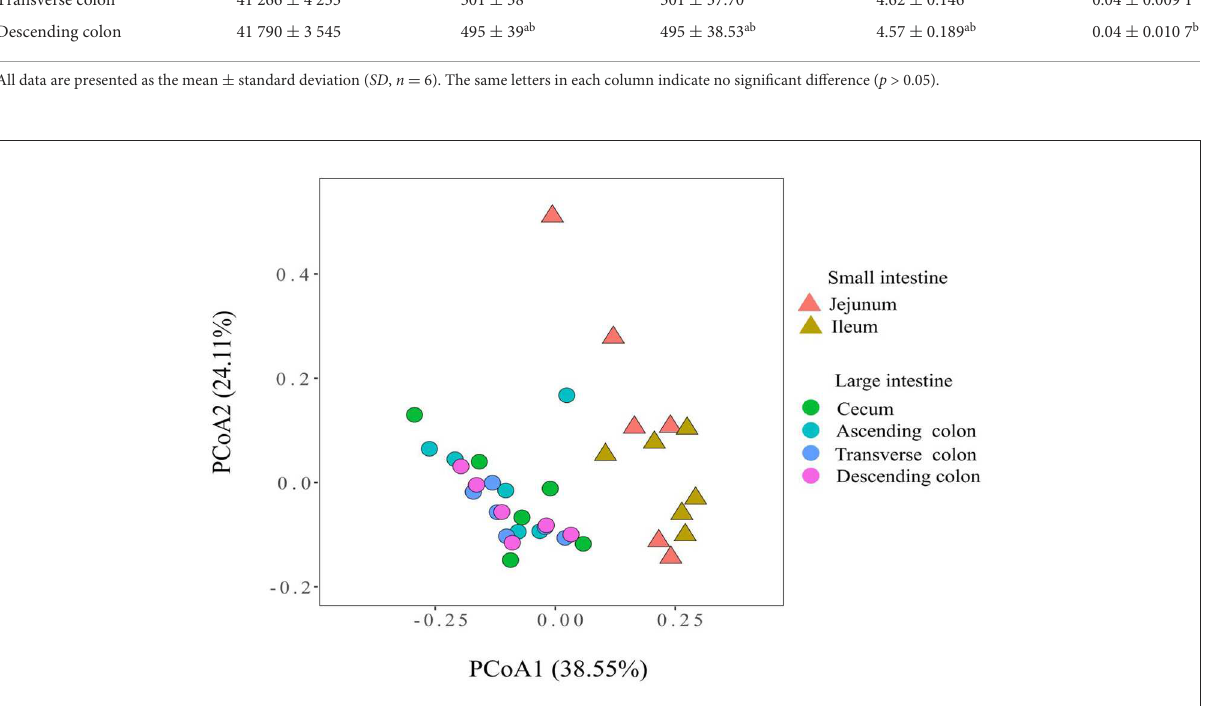
FIGURE1 Principal coordinate analysis of the microbial communities based on the weighted UniFrac